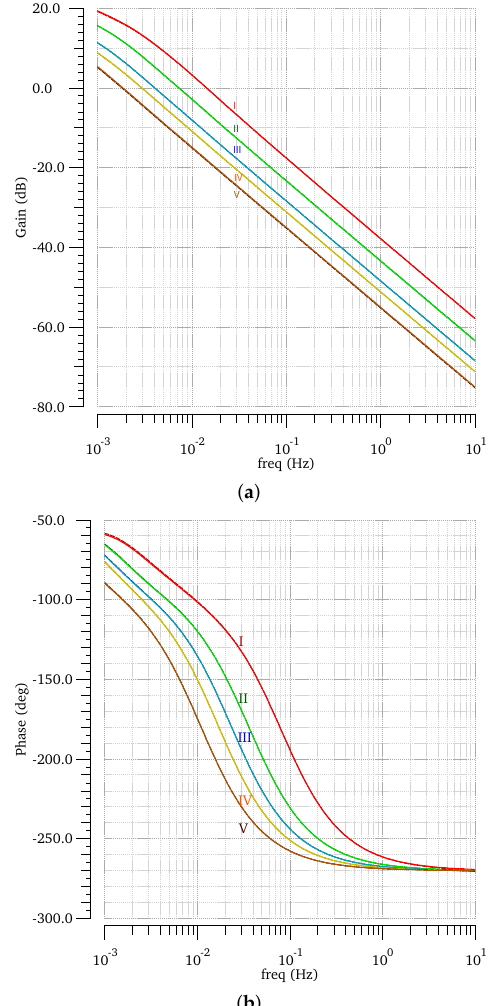
Figure 18. Post-layout simulation results showing the ( a ) gain and ( b ) phase responses of the open- loop